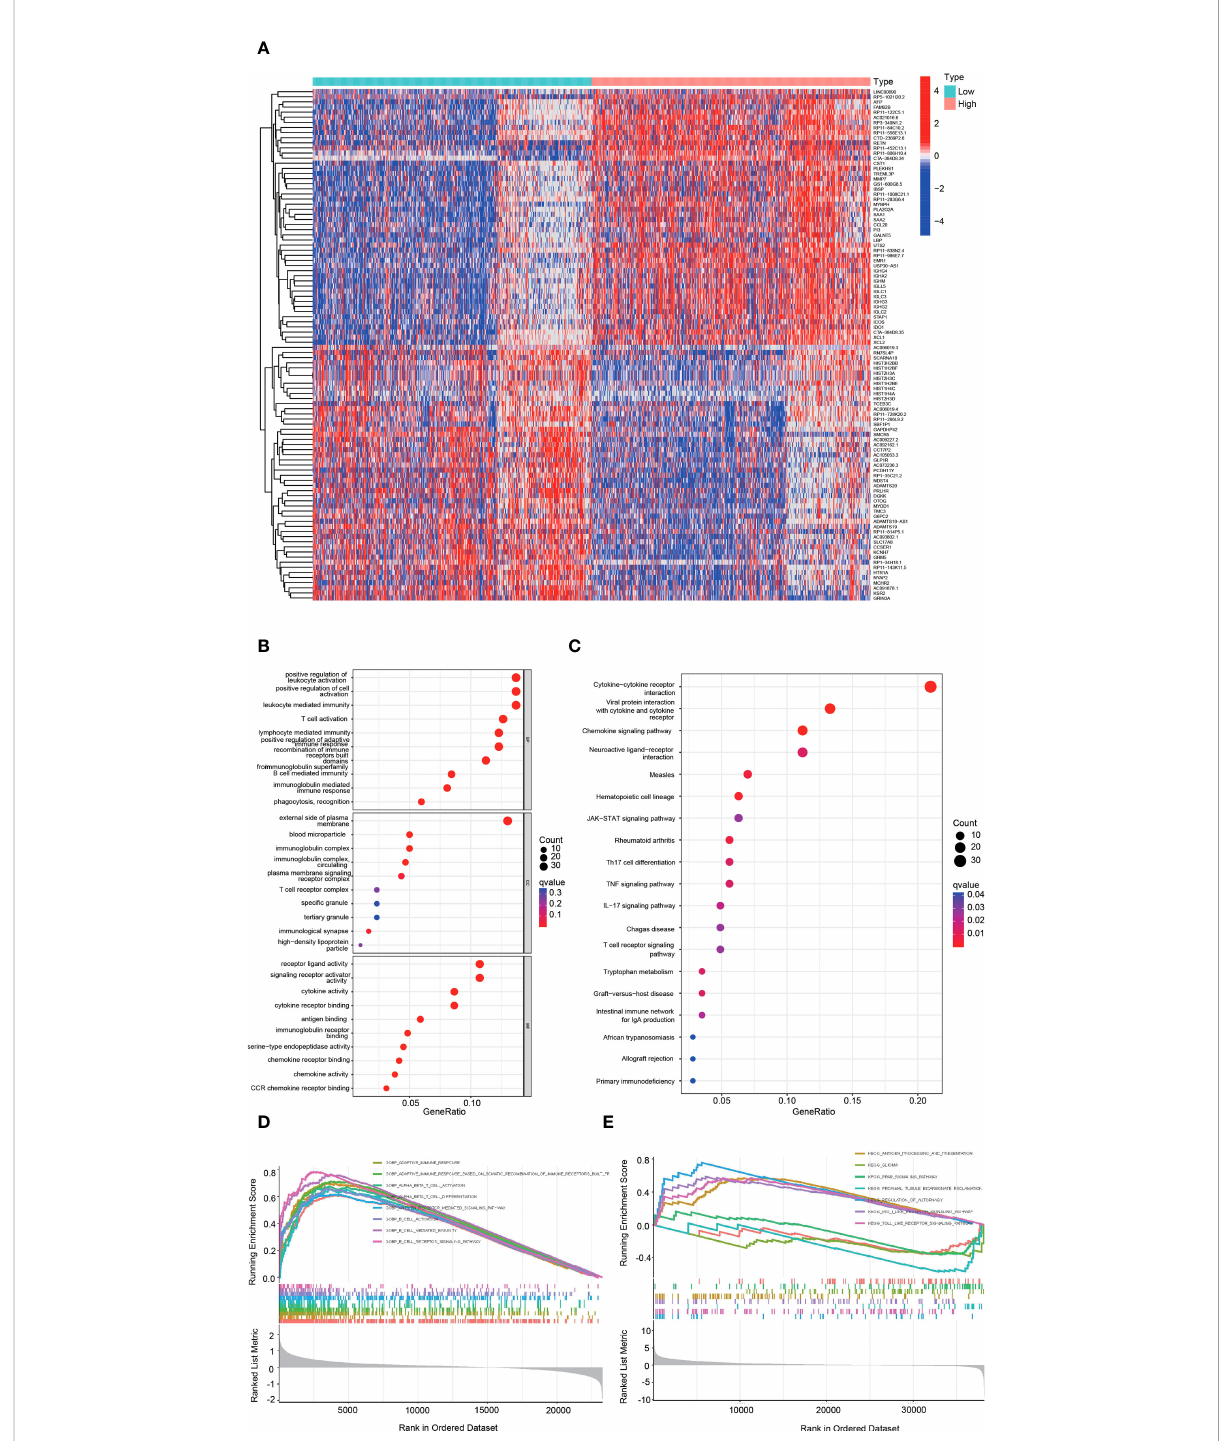
FIGURE 6 Functional analysis of DEGs between the high and low hepcidin expression groups in the CGGA dataset. (A) Heatmaps of the differentially expressed genes between the high and low hepcidin expression groups. (B, C) GO and KEGG analyses of DEGs. (D, E) GSEA-GO (D) and GSEA- KEGG (E) enrichment analyses of the high and low hepcidin expression groups in the CGGA